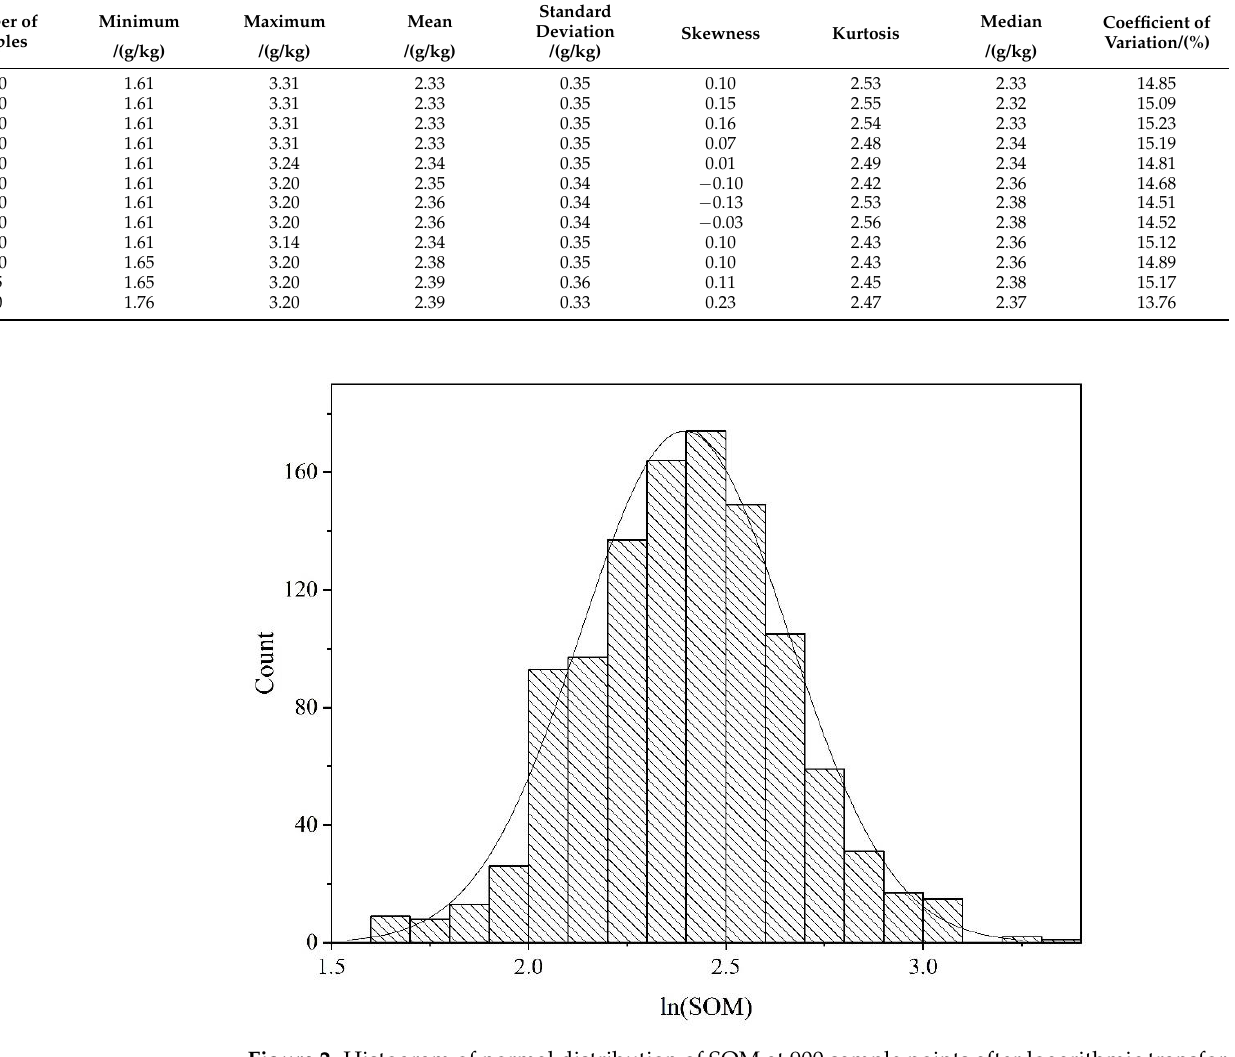
Figure 2. Histogram of normal distribution of SOM at 900 sample points after logarithmic transfor- mation.